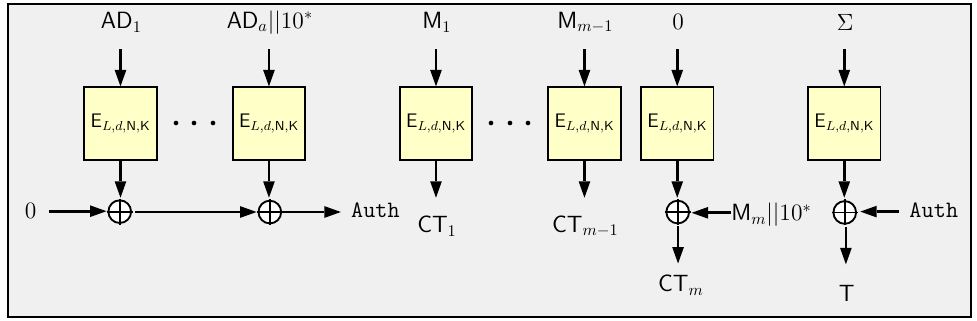
Figure 12: The high-level view of SKINNY-AEAD . The block counter L , a domain separator d , the nonce N and the encryption key K together make up the 384-bit tweakey. The encryption of the zero string is only performed when the last message block is incomplete.